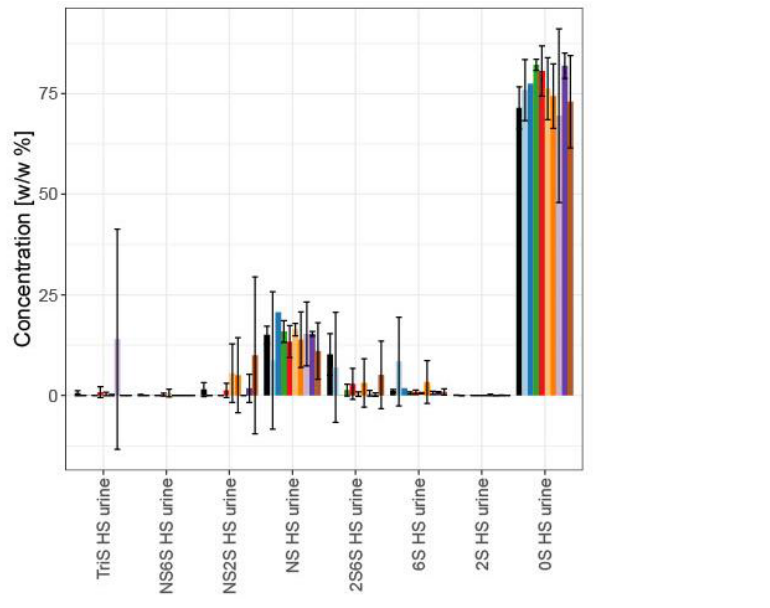
Figure 2. Relative concentration (in mass fraction %) of CS (upper panel) and HS (lower panel) disaccharides in the groups. SMDK: spondylometaphyseal dysplasia-Kozlowski type. ML II: mucolipidosis type II. See also Table S2.